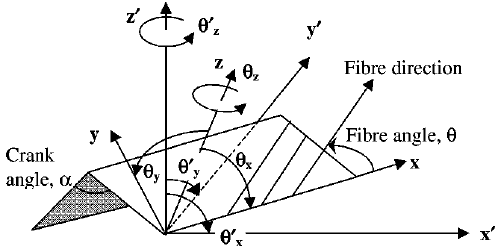
Fig. 2. Local (unprimed) and global (primed) axes system for a typi- cal folded plate element. The least angle contained between positive x 0 and x axes is denoted as ( x 0 , x